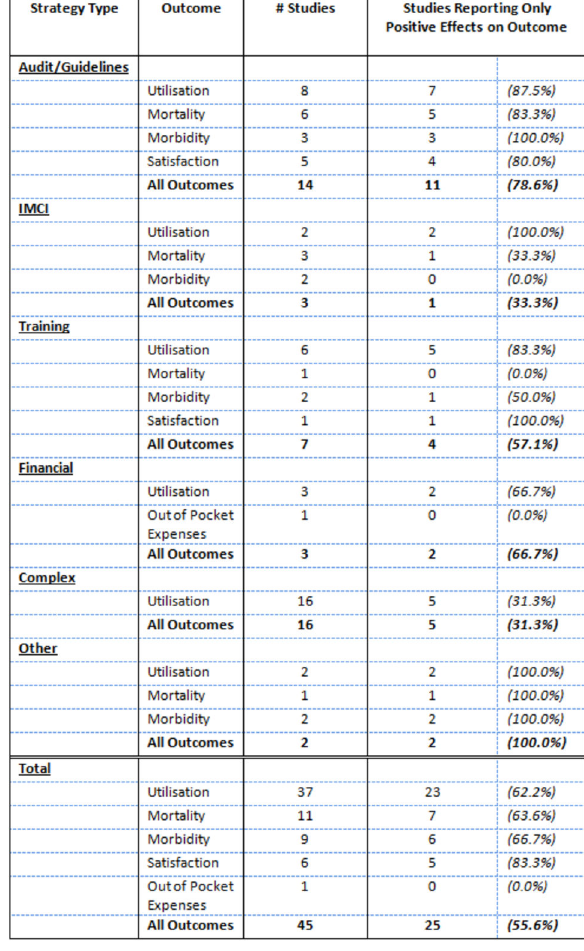
Figure 3. Proportion of Studies Reporting Positive Effects for Given Outcomes by Strategy Type. Notes: Effects were considered positive if the authors reported the result as being beneficial. If multiple indicators existed for the same type of outcome it was only considered positive if all results were reported as being